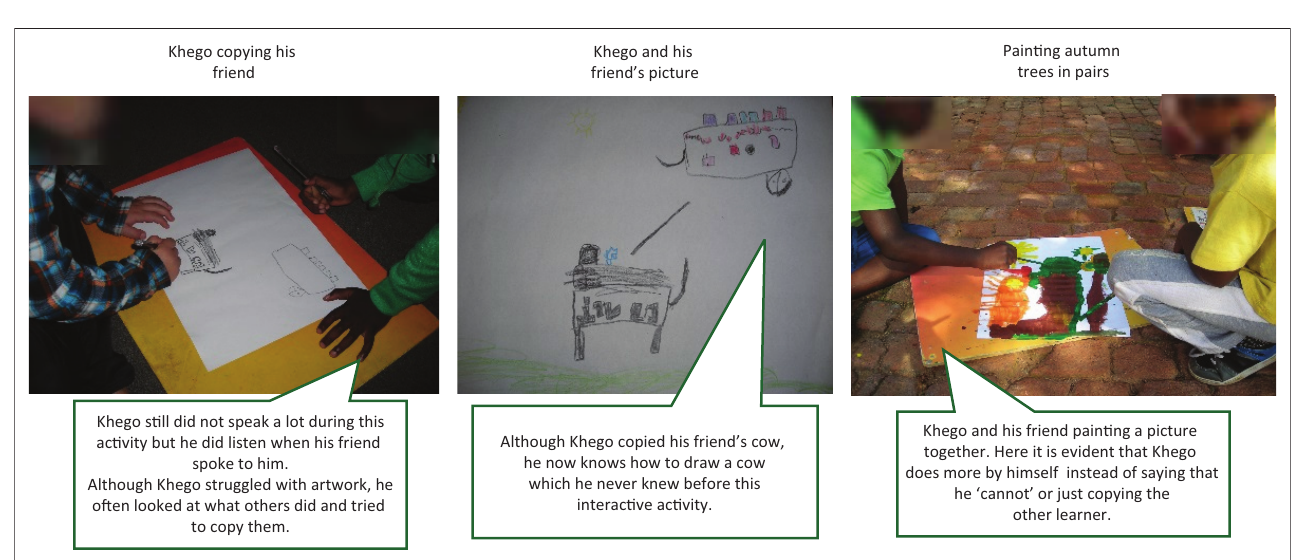
FIGURE 3: Verne became a more relaxed and happy learner.